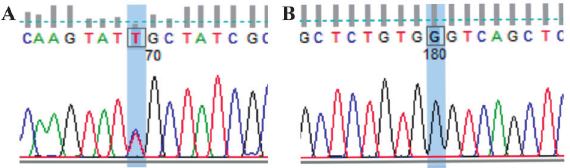
Figure 2. DNA sequencing of Patient 1. A , Analysis of exon 5 of the BCKDHB gene: base C (blue) was exchanged by T (red) - R168C. B , Analysis of exon 9 of the DBT gene: base A (green) was exchanged by G (black) -